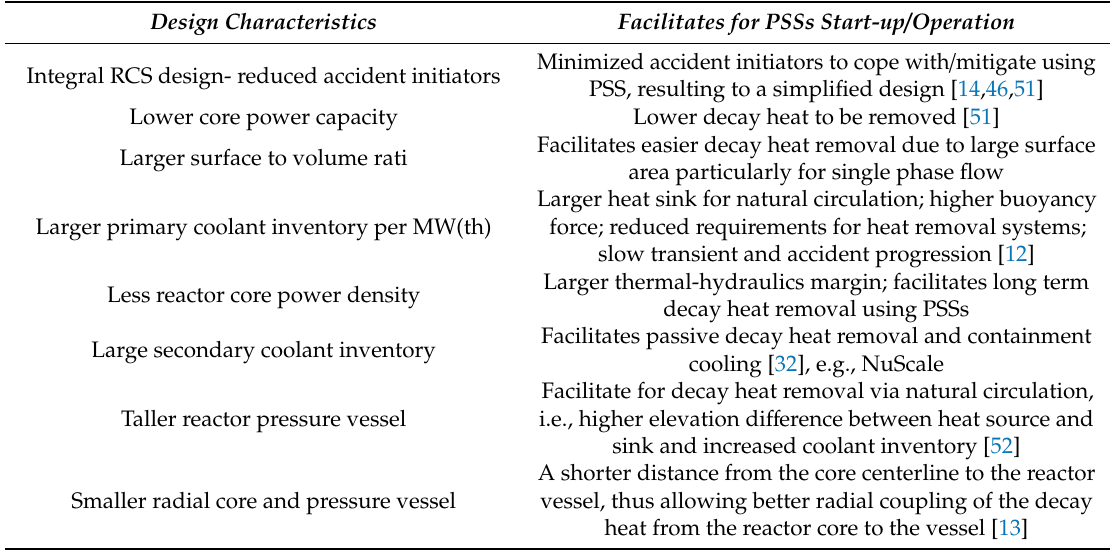
Table 4 list expected advantages of implementing PSSs in iPWR-type SMRs. Table 4. Potential advantages of implementing passive safety systems (PSSs) in iPWR-type SMRs .